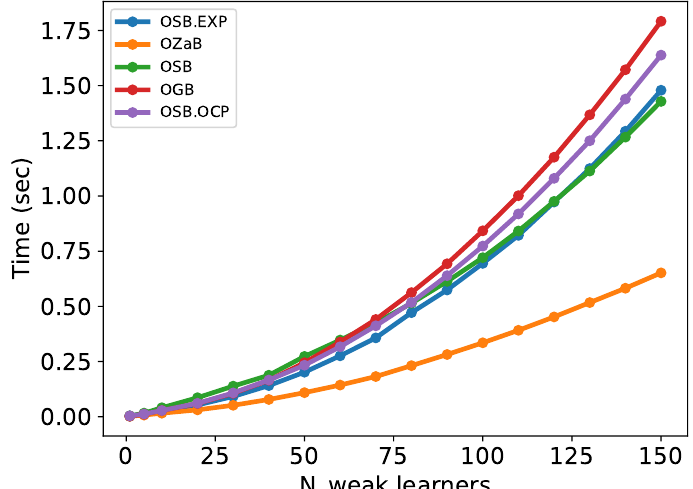
Figure 6. Comparison of computational time for online boosting algorithms.